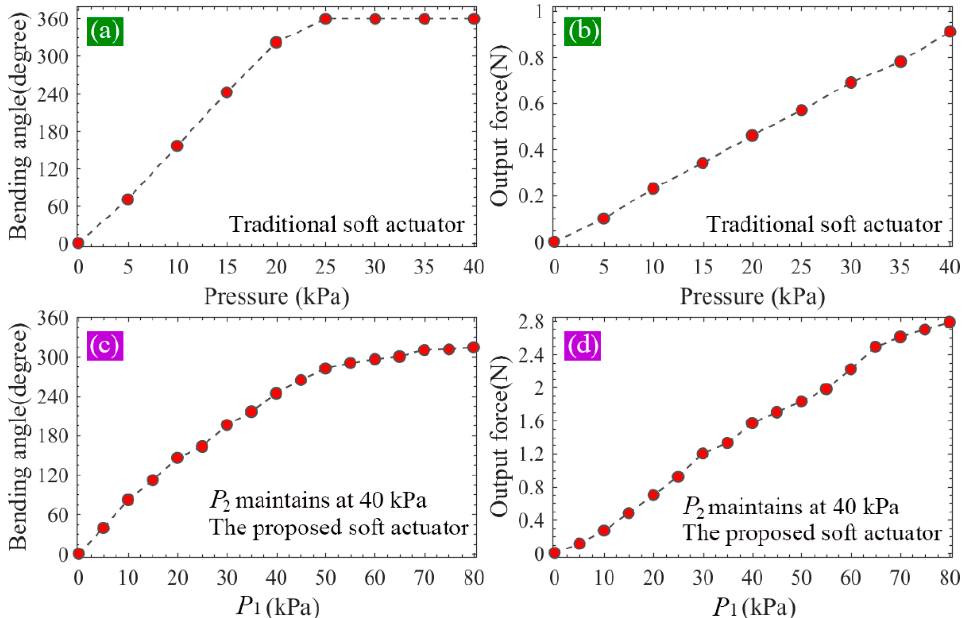
Figure 10. ( a , b ) The bending angle and output force of the traditional soft actuator under different pressures and ( c , d ) the bending angle and output force of the proposed soft actuator against the pressure under different pressures.